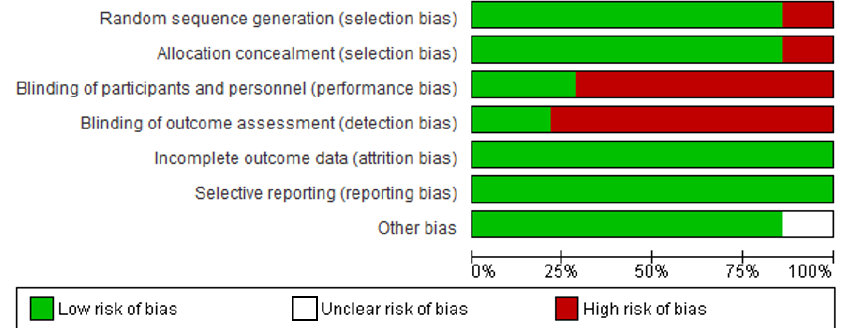
Figure 3. Graph of Reviewers’ Assessments of Each Study’s Risk of Bias.